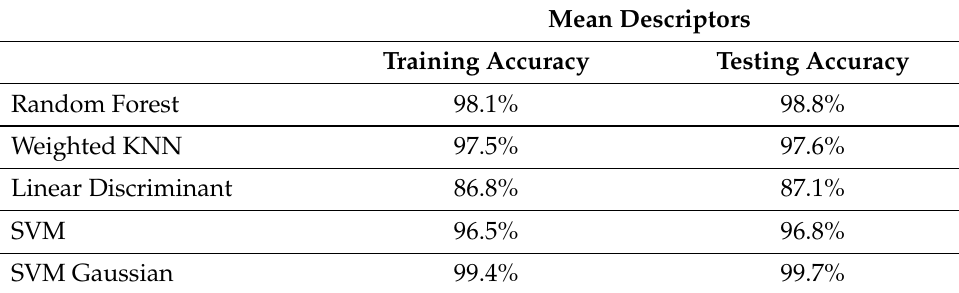
Table 6. Accuracy rate for model with mean descriptors only.